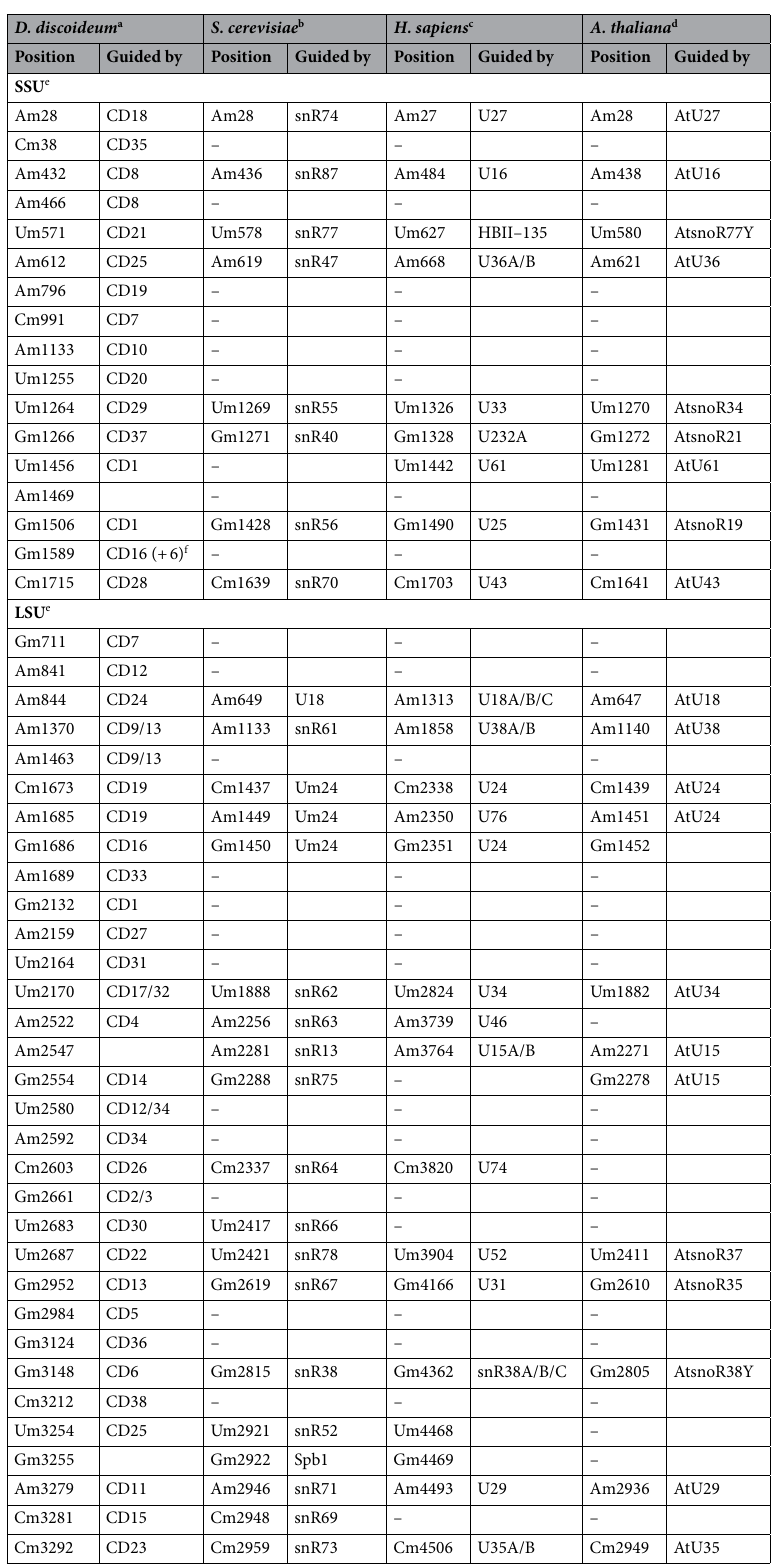
Table 1. Sites of 2 ′ -O-methylation in rRNA with guiding box C/D snoRNAs in D. discoideum and further species. a This study. b https:// people. bioch em. umass. edu/ fourn ierlab/ snorn adb/ maste rtable. php. c https:// www- snorna. bioto ul. fr/ human_ yeast/. d https:// ics. hutton. ac. uk/ cgi- bin/ plant_ snorna/ home. e SSU small subunit, LSU large subunit. f (+ 6) denotes a deviation of the + 5 consensus methylation target